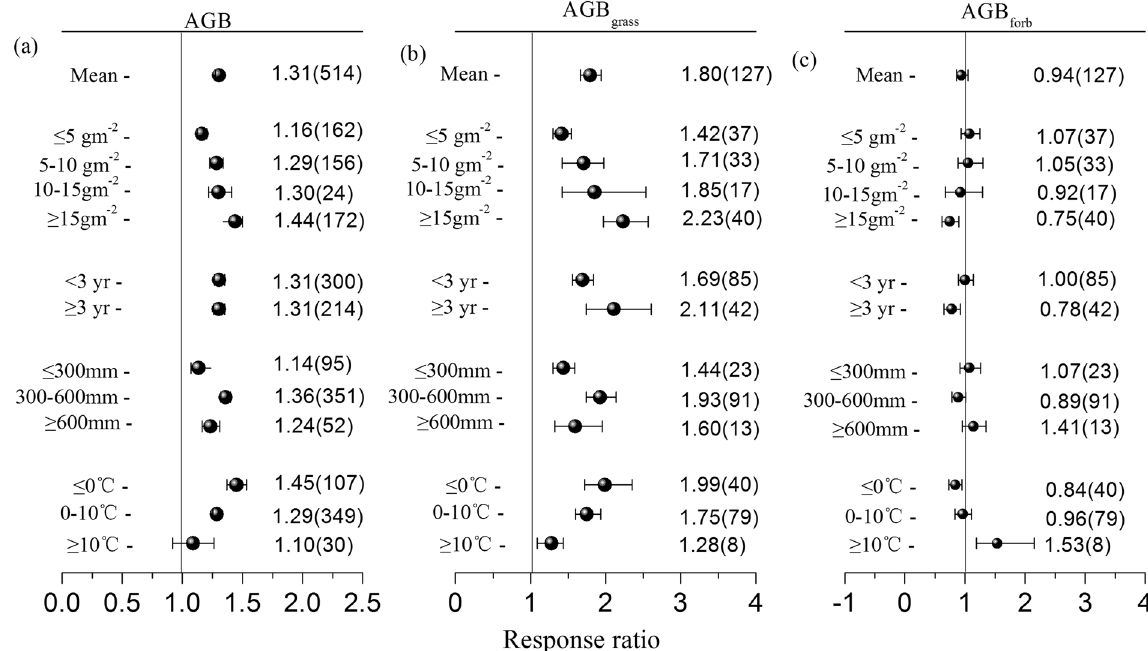
Figure 2. Effects of nitrogen (N) addition on aboveground biomass (AGB) ( a ), the AGB of grasses (AGB grass ) ( b ), and the AGB of forbs (AGB forb ) ( c ) under different N addition rates, study durations, and climatic conditions. The numbers outside and inside the parentheses represent the response ratio (RR) and the number of observations, respectively. The dots with error bars are the means with 95% confidence